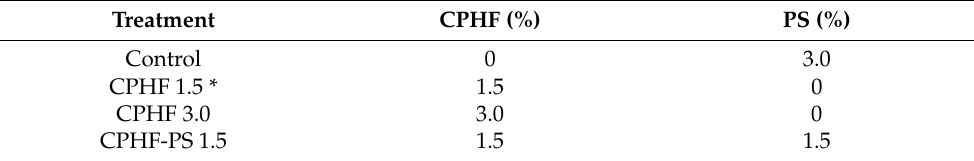
Table 1. Treatments in the frankfurter elaboration. Treatment CPHF (%) PS (%) Control 0 3.0 CPHF 1.5 * 1.5 0 CPHF 3.0 3.0 0 CPHF-PS 1.5 1.5